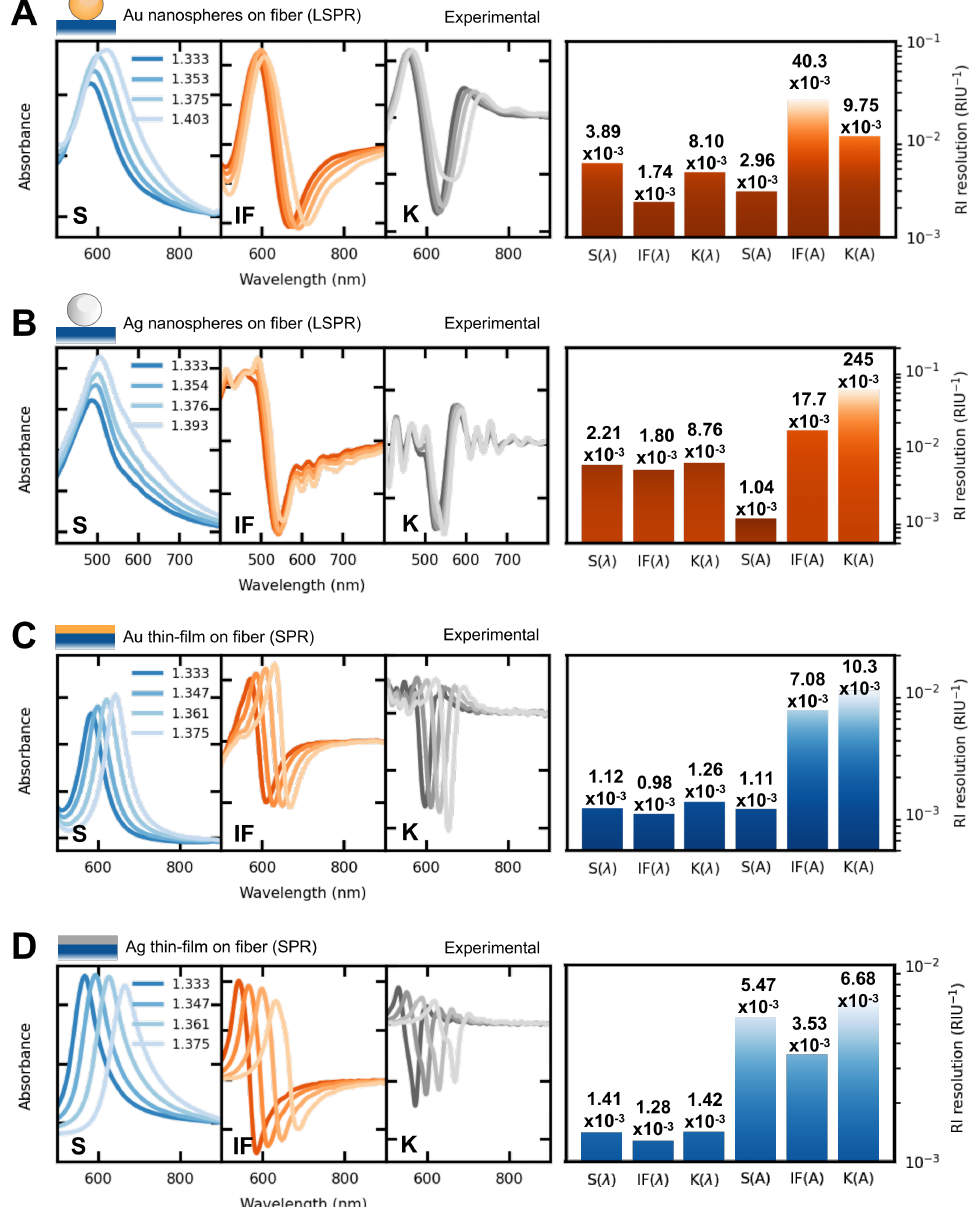
Figure 4. Refractometric response in terms of spectral changes and measurement resolution of the derivatives) were studied. In this way, the resolution for each method could be